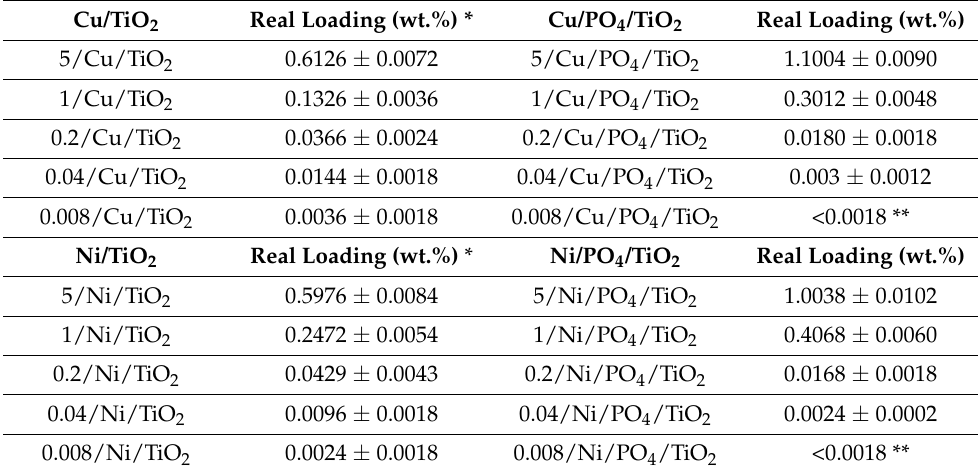
Table 1. Summary data of the achieved real loadings, determined through TXRF for Cu (above) and Ni (below) and both TiO 2 and PO 4 /TiO 2 support series. Cu/TiO 2 Real Loading (wt.%) * Cu/PO 4 /TiO 2 Real Loading (wt.%) 5/Cu/TiO 2 0.6126 ± 0.0072 5/Cu/PO 4 /TiO 2 1.1004 ± 0.0090 1/Cu/TiO 2 0.1326 ± 0.0036